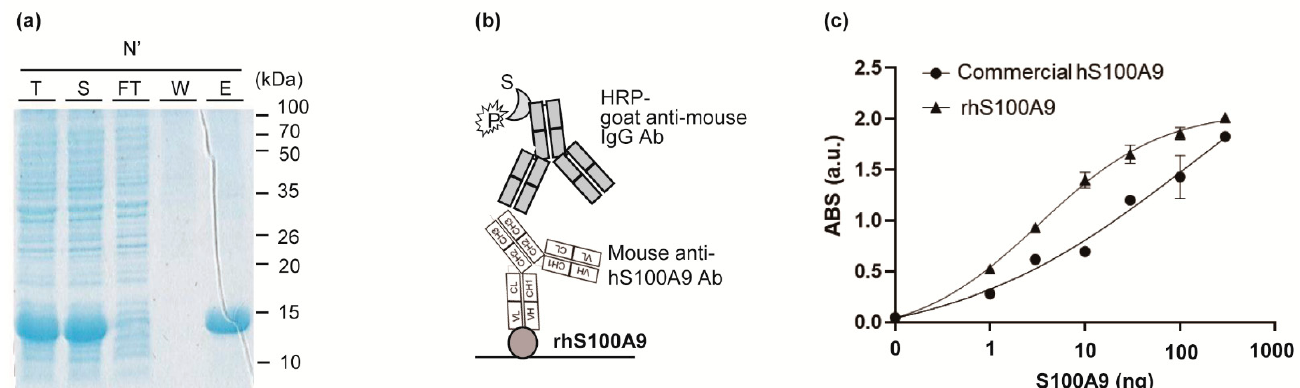
Figure 1. ( a ) SDS-PAGE analysis of Ni-NTA purified rhS100A9. T, S, FT, W, and E indicate total protein, soluble protein, flow through fraction, wash fraction, and elution fraction, respectively. ( b ) Schematic representation of the indirect ELISA for confirming the antibody-binding activity of purified rhS100A9. ( c ) ELISA titer with different concentrations of rhS100A9 or commercial hS100A9.